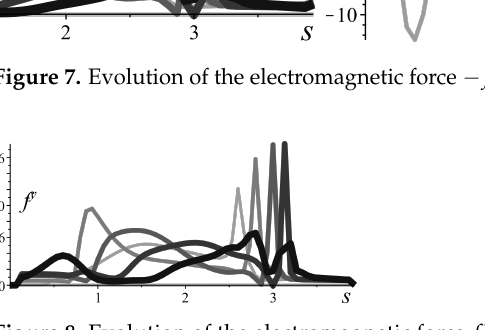
Figure 8. Evolution of the electromagnetic force f y for the third experiment ( H 0 >